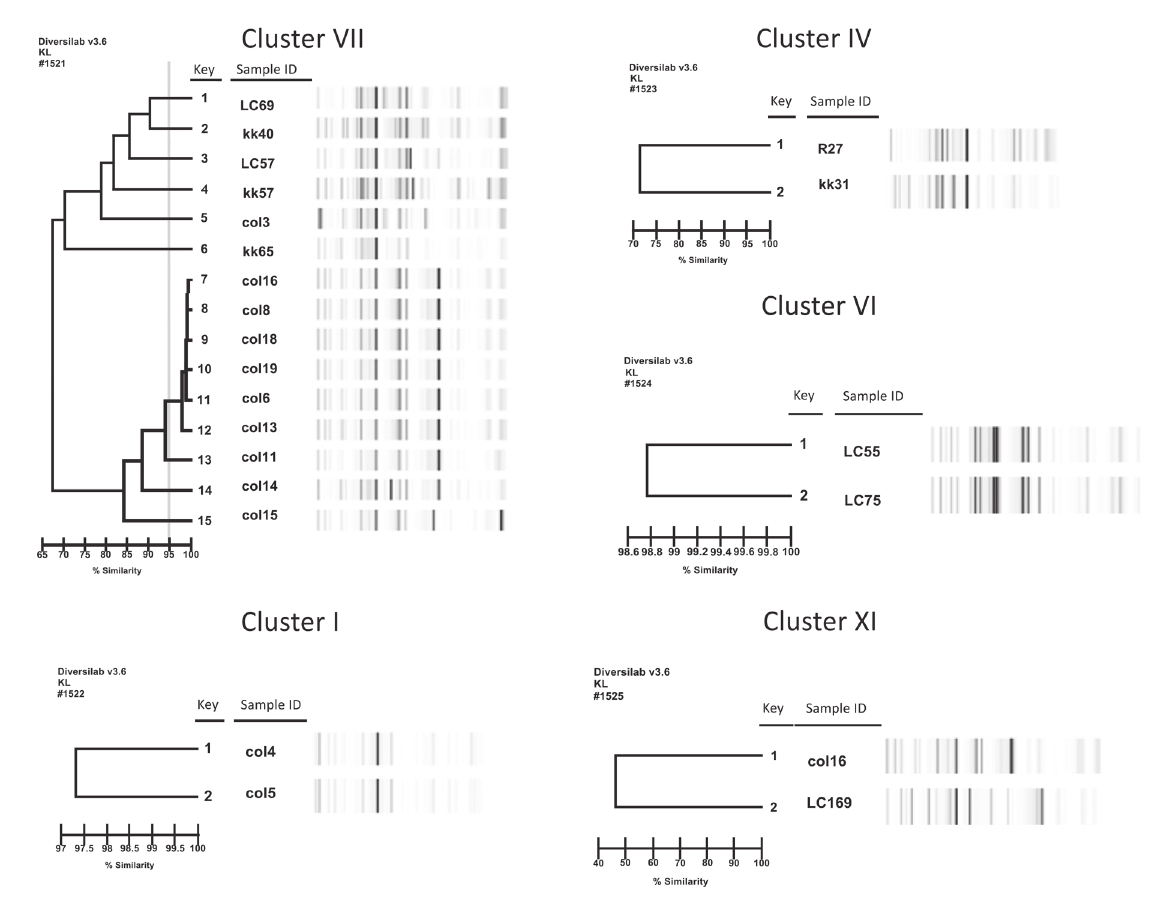
Figure 1. rep-PCR of selected samples by hsp60